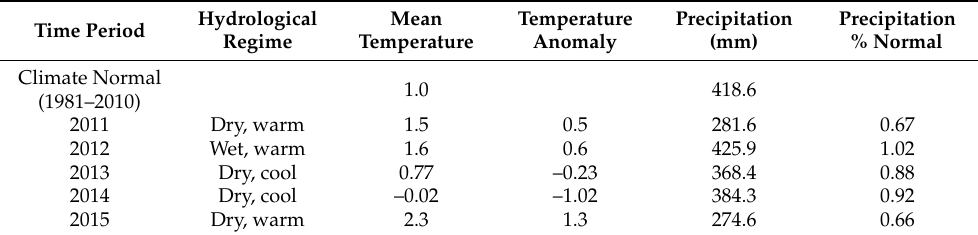
Table 1. Temperature and precipitation recorded during the study compared to climate